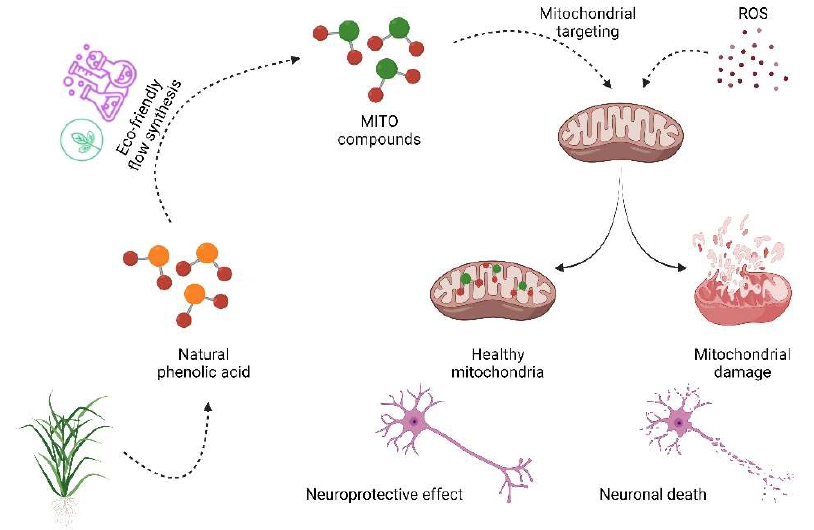
Figure 5. Schematic representation of the effects of the MITO compounds. Created with BioRender.com.